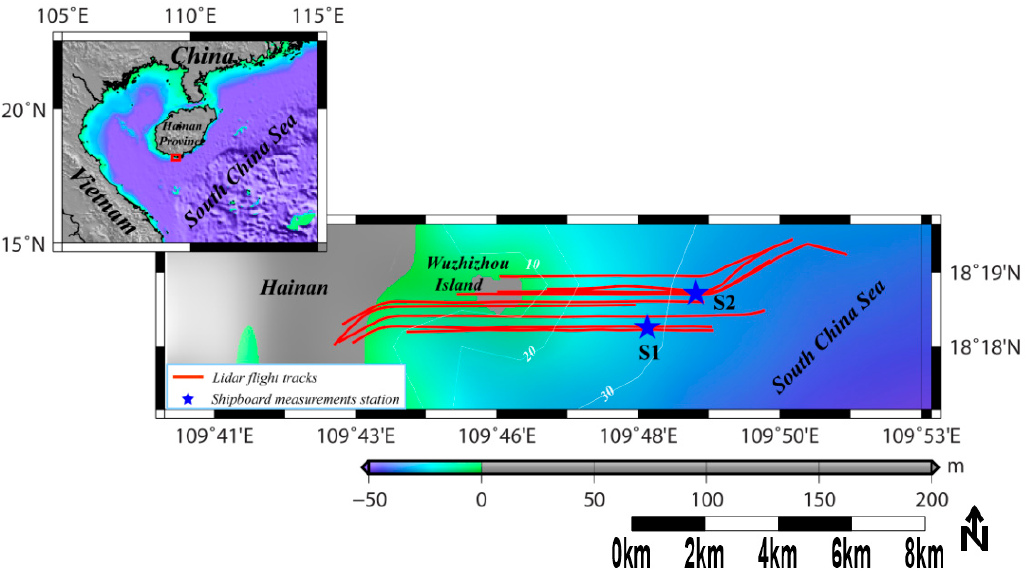
Figure 1. Study area in Wuzhizhou Island of Hangtang Bay, in the South China Sea. The red lines are airborne LiDAR flight routes taken on 30 September 2017. The blue stars are the shipboard synchronous in situ calibration stations.